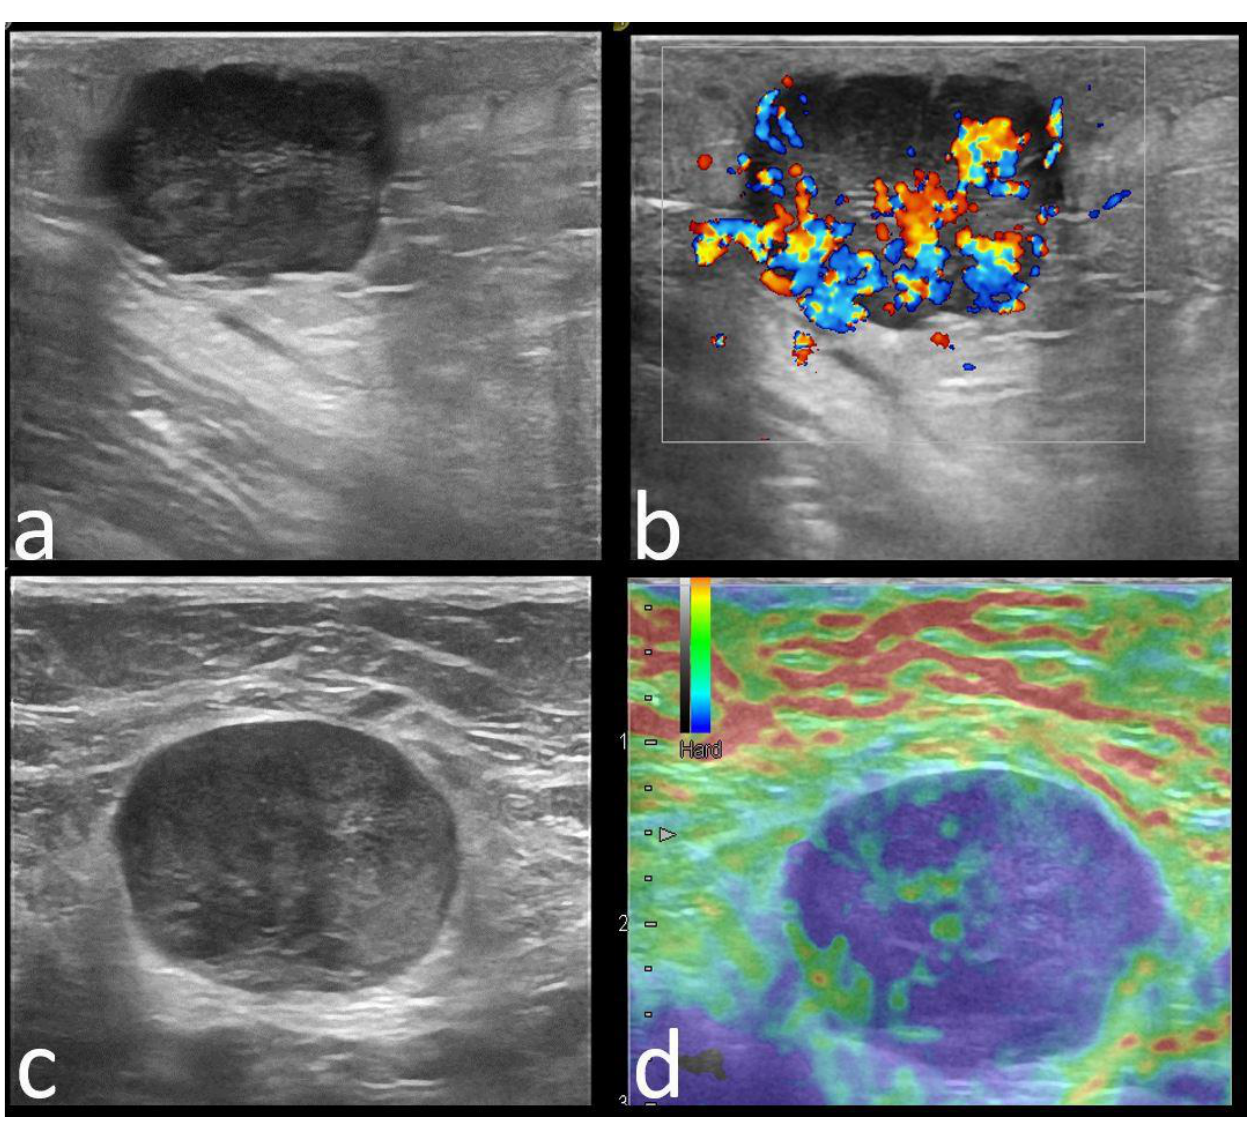
Figure 3. Upper images: 29-year-old TP53 mutation carrier patient with right breast cancer. There is an oval, hypoechoic mass with microlobulated margins, parallel orientation compared to skin, with acoustic enhancement ( a ) and internal vascularity ( b ). Skin invasion was suspected and confirmed later by pathology. Pathology: IDC-NST, ER/PR/HER2-negative, ki67 = 90%. Lower images: 62-year-old PALB2 mutation carrier patient with right breast cancer. There is an oval, hypoechoic mass with circumscribed margins, parallel orientation compared to skin ( c ), mild acoustic enhancement, and soft elastography appearance (TSUKUBA score 3, d ). Pathology: IDC-NST, ER/PR-negative, HER2-positive, grade 2, Ki67 = 80%.